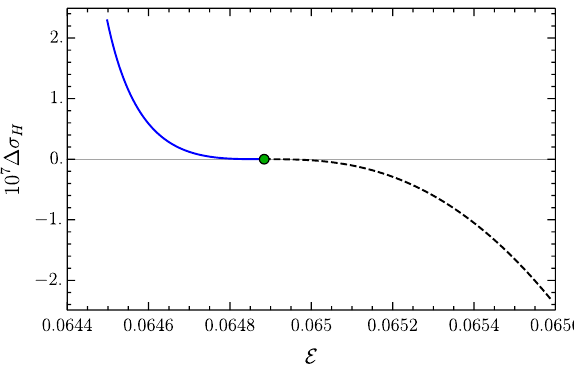
Figure 2 . Phase diagram in the microcanonical ensemble for (cid:13) = 1 = 2: entropy density di(cid:11)erence (cid:1) (cid:27) H between the triangular (upper blue curve) or hexagonal (lower black curve) nonuniform black branes and the uniform black brane for a given energy density E . The green dot locates where the uniform black brane is critically unstable, with lower energies being fully unstable.